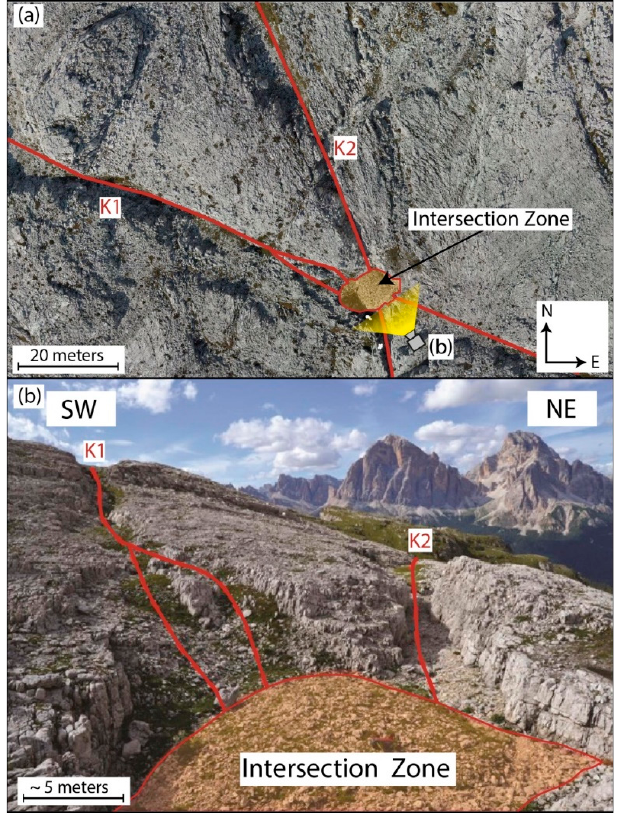
Figure 13. Trenches at the fault core and intersection zone of K1 and K2 faults on the top of the Lastoni di Formin platform as it appears in the UAV ‐ photographs ( a ) and in the field ( b ). Note the large trenches that characterize the fault core and the depression zone formed at the intersection between the two faults.